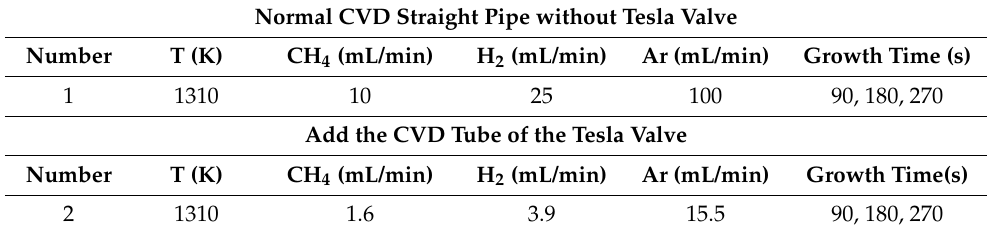
Table 3. Comparison test